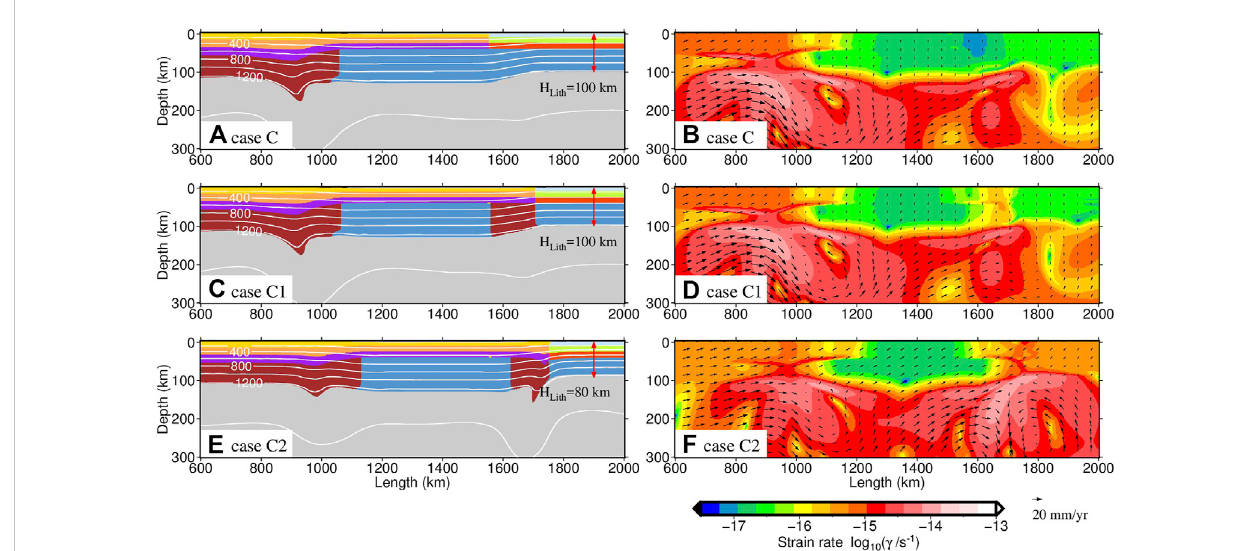
FIGURE 8 Comparisons of lithospheric deformation (A,C and E) and strain rate localization (B,D and F) for different cases (cases C, C1, and C2) after 10 Myr convergent. Different colorsin (A,C and E) indicates different materials, whichare consistent with that inFigure2A. White lines in (A,C and E) indicate the isotherm. Black arrows in (B,D and F) show velocity vectors.